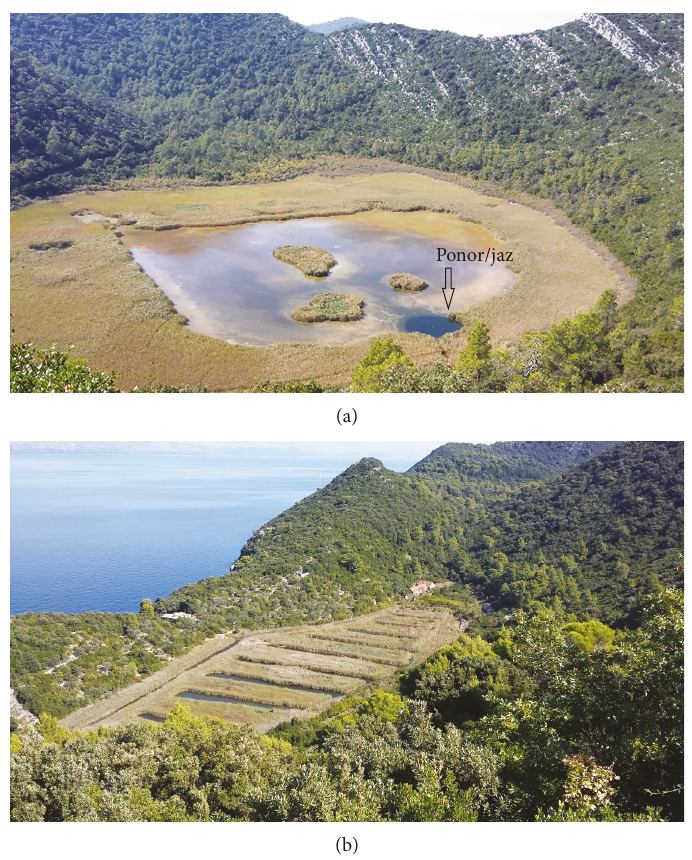
Figure 4: Blatska blatina in Blato — situated furthest from the sea (a) and blatina Slatina in Kozarica — closest to the sea both laterally and vertically and with known conduit toward the sea